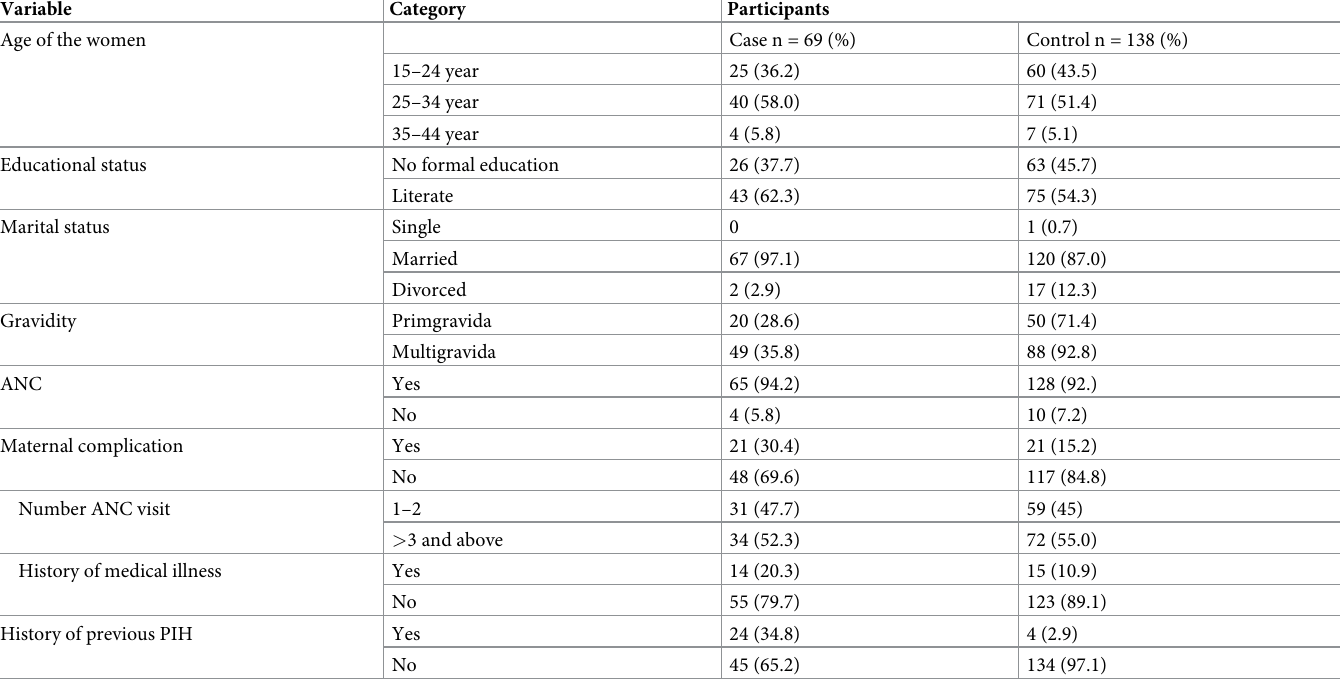
Table 2. Cross tabulation of socio-demographic and RH among women gave birth at public health facilities, in Hossana town administration, Southern Ethiopia, 2018. Variable